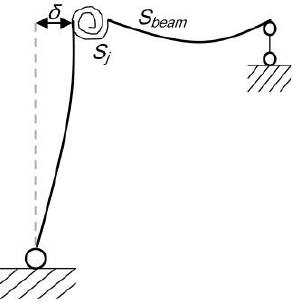
Figure 6. An equivalent column with a rotational